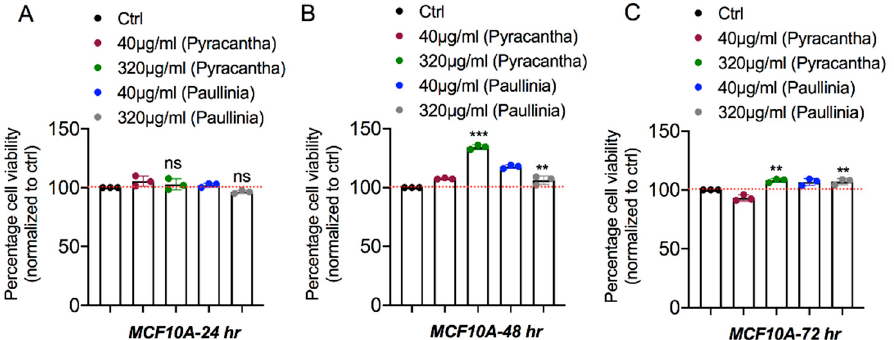
Figure 4. Cell viability screening analysis of different extracts from eight medicinal plants in human hepatocellular carcinoma HEPG2 cells. The alamarBlue assay was performed in Paullinia ( A ), Saururus ( B ), Sorbus ( C ), Quercus ( D ), Pyracantha ( E ), Ficus ( F ), Colocasia ( G ), and Delonix (H) extract-treated (0, 10, 40, 160, or 320 µ g · mL –1 ) cells after 24, 48, and 72 h of incubation. ** p < 0.01; *** p < 0.001. Untreated samples were used as controls for all tested plant extracts.